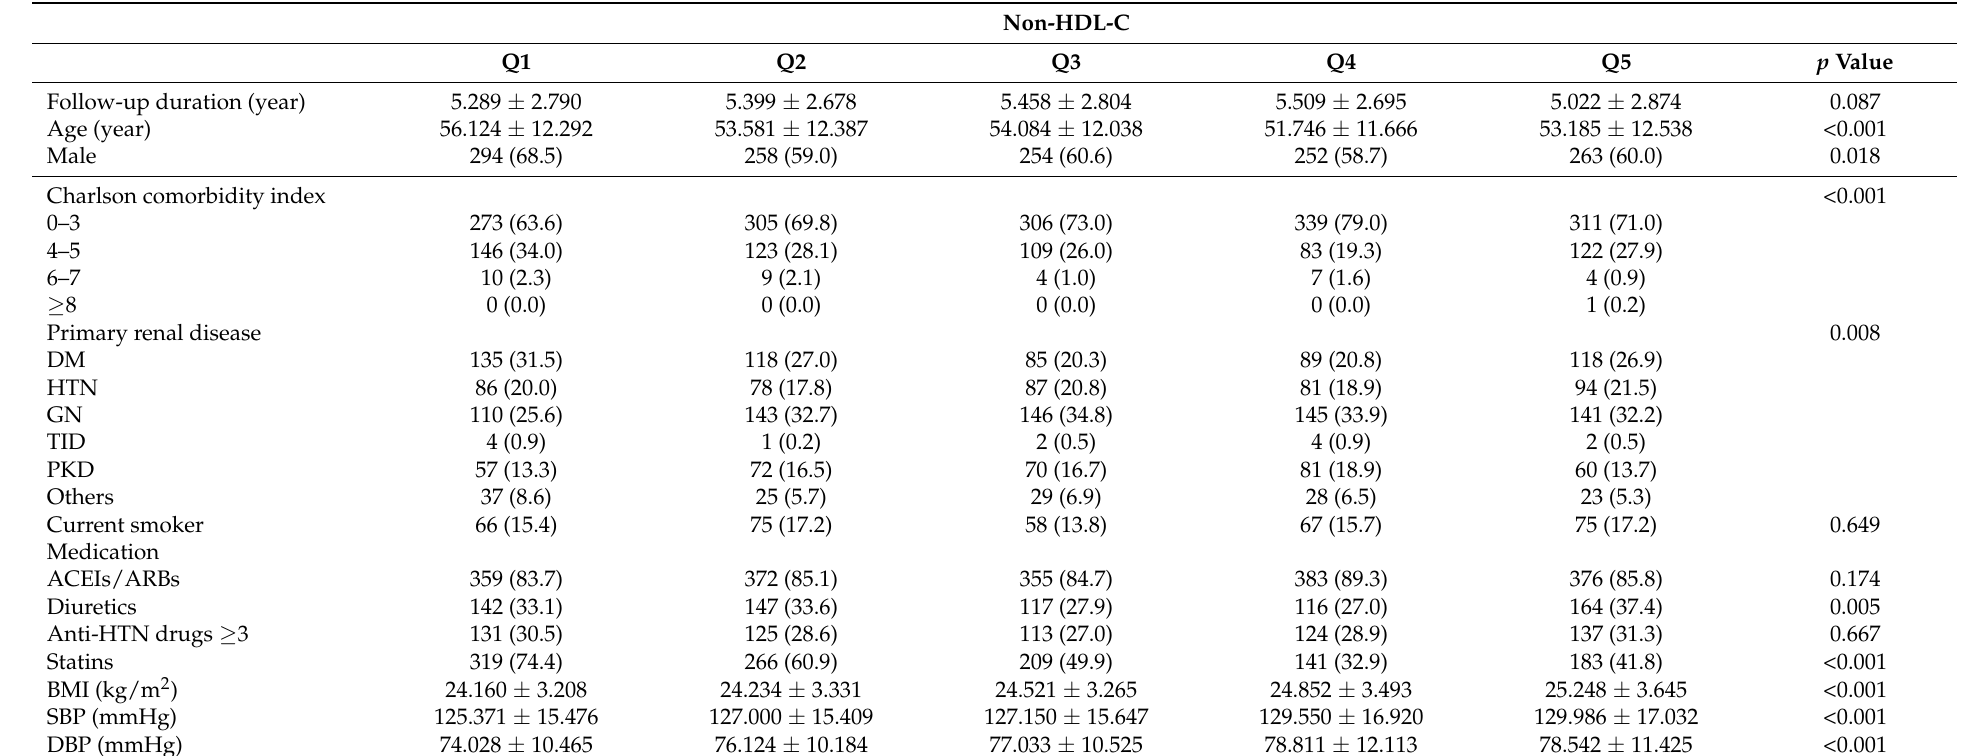
Table 1. Baseline characteristics of study participants by non-HDL-C